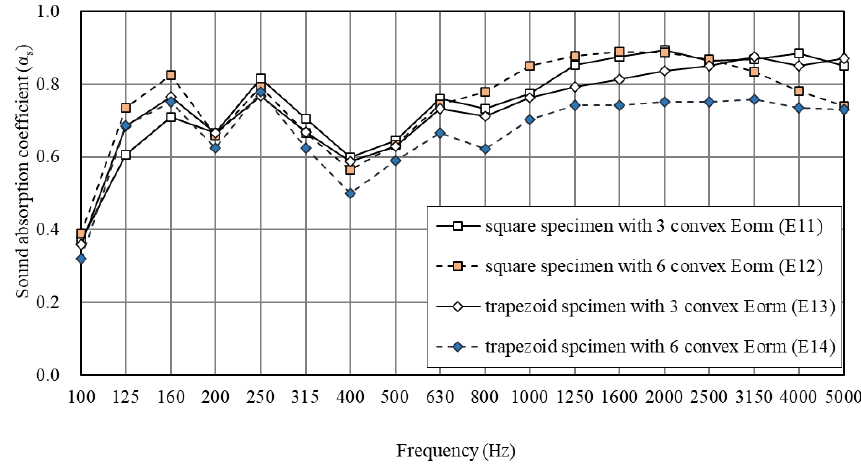
Figure 11. The sound-absorption coefficient of 30 mm FEMM with a 450 mm cavity.